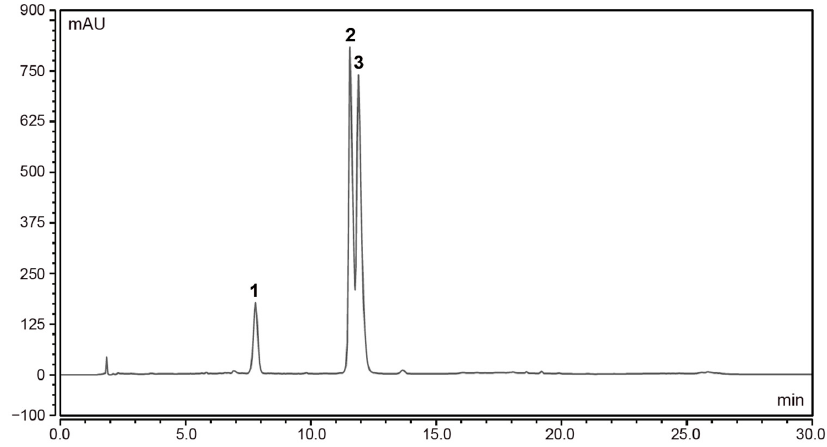
Figure 1. The HPLC chromatogram of anthocyanins in EC 3.2. Peak 1: cyanidin-3-sambubioside-5-glucoside; peak 2: cyanidin-3-sambubioside; peak 3: cyanidin-3-glucoside. Absorbance (mAU) measured at 520 nm.